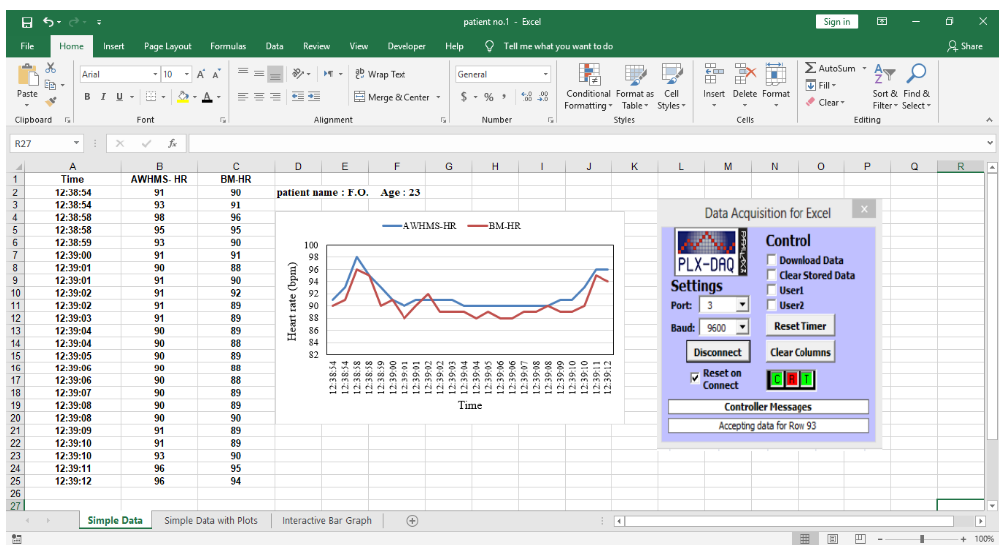
Figure 7. Data acquisition program based on PLX-DAQ for HR and BM measurement.